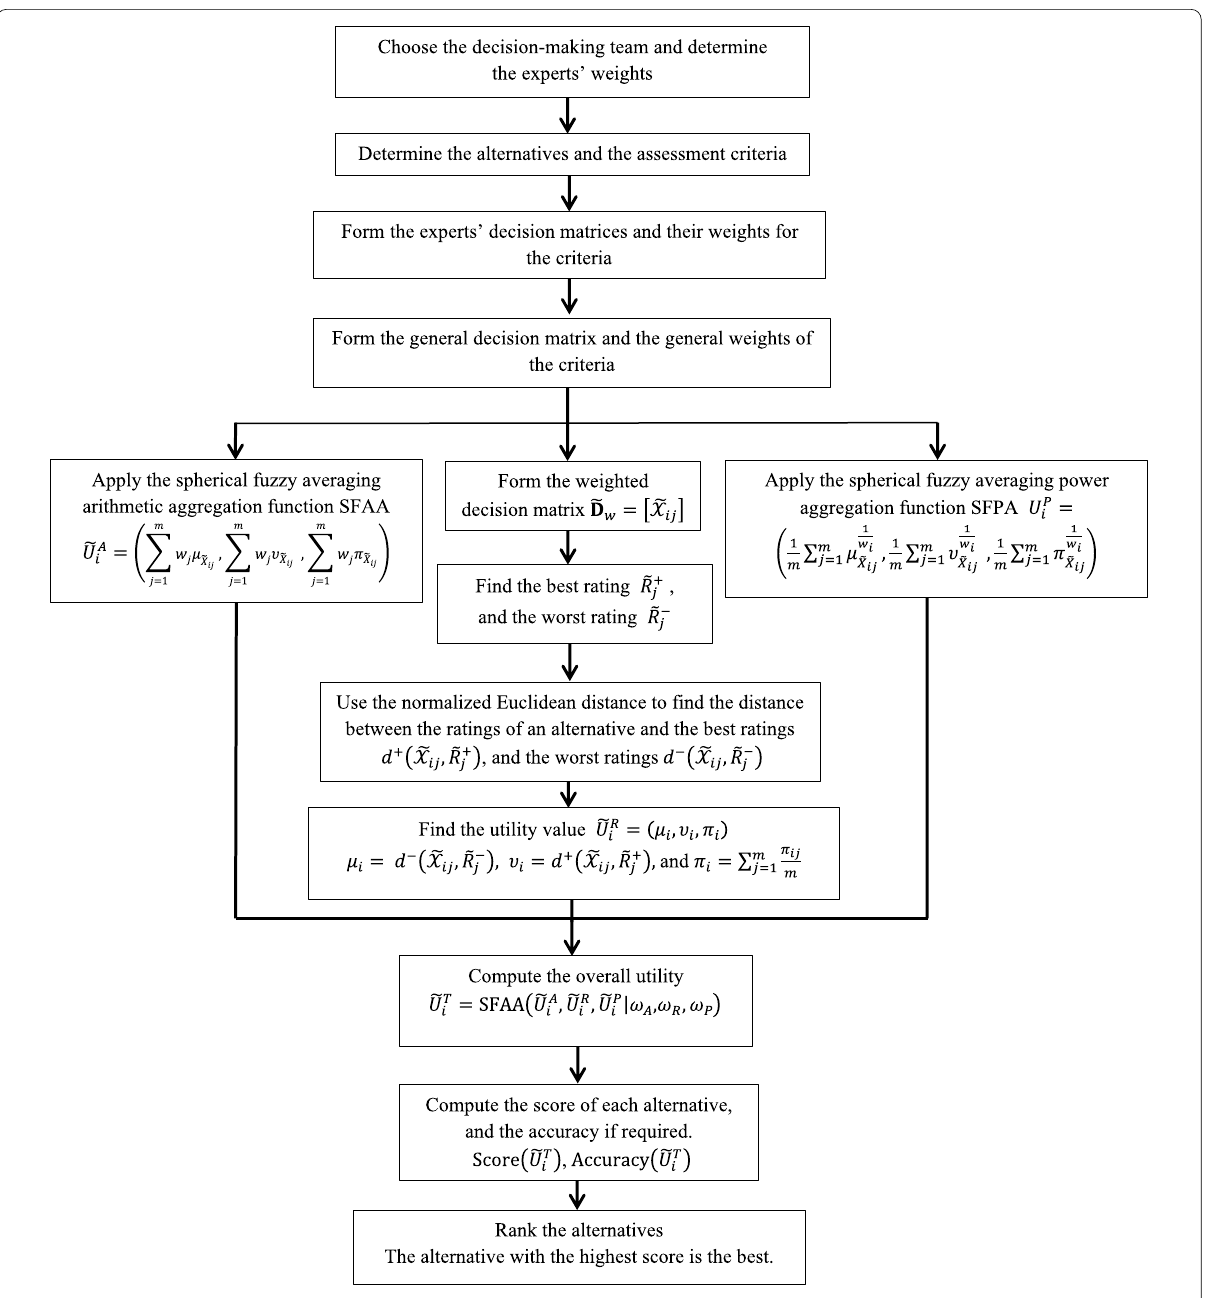
Figure 1 A flowchart of the proposed